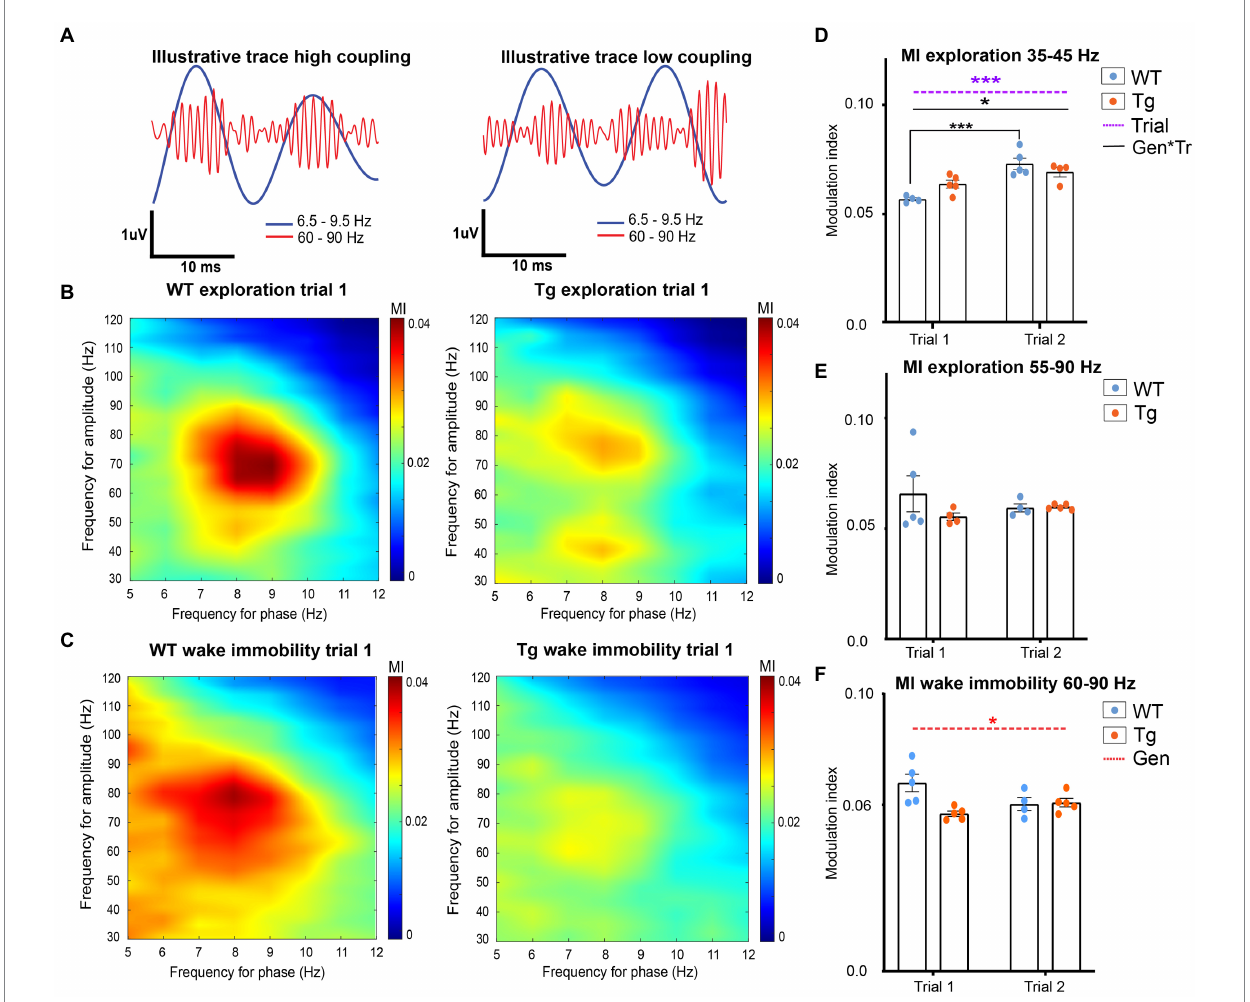
FIGURE 3 Hippocampal theta-gamma coupling in TgF344-AD rats during exploration and wake immobility. (A) Illustrative filtered traces (theta range in blue, gamma range in orange) of a respective wildtype (WT) and TgF344-AD (Tg) subject during exploration. The amplitude of the gamma oscillations in the left trace demonstrated high coupling to the phase of theta, whereas the amplitude of the gamma oscillations is less coupled to the theta phase. Average comodulograms demonstrate main frequencies of modulation during exploration (B) and wake immobility (C) in WT rats (left) and Tg rats (right). Colors indicate the strength of the PAC as calculated by the modulation index (MI) for different frequencies of theta ( x -axis, phase-determining frequency) and gamma ( y -axis, frequency for amplitude) (paragraph 2.2.5.3). Comodulograms demonstrate coupling between 6.5–9 Hz and 35–45 Hz, and 6.5–9 Hz and 55–90 Hz during exploration. During wake immobility, coupling between 6.5–9 Hz and 60–90 Hz were observed. These results were used to investigate the coupling strength for each 1-s epoch between these specific frequency bands, to obtain subject averaged time-resolved MI. (D–F) time resolved PAC analysis results (paragraph 2.2.5.3). (D) Time-resolved averaged MI between theta (6.5–9 Hz) and gamma frequencies (35– 45 Hz) during exploration. (E) Time-resolved averaged MI between theta (6.5–9.5 Hz) and gamma frequencies (60–90 Hz) during wake immobility. (F) Time-resolved averaged MI between theta (6.5–9.5 Hz) and gamma frequencies (60–90 Hz) during wake immobility Bars indicate mean MI (±SEM), dots represent subject values. * p ≤ 0.05, ** p ≤ 0.01, *** p ≤ 0.001/ q ≤